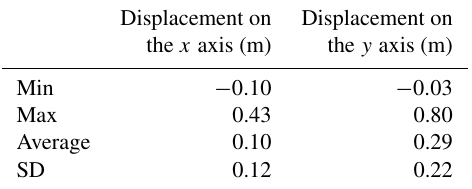
Table 2. Summary of coordinate differences between real route and MTi-IMU positioning results (indoor environment).